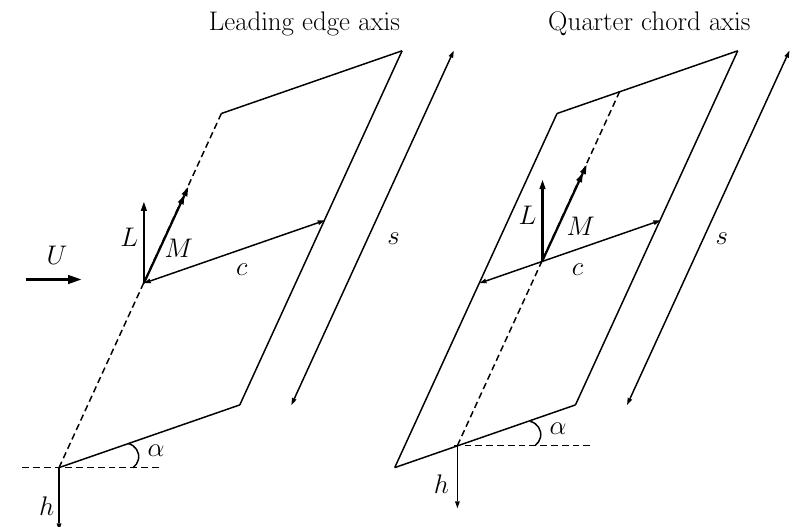
Figure 3. Rectangular wing with pitch axis at the leading edge and quarter chord.